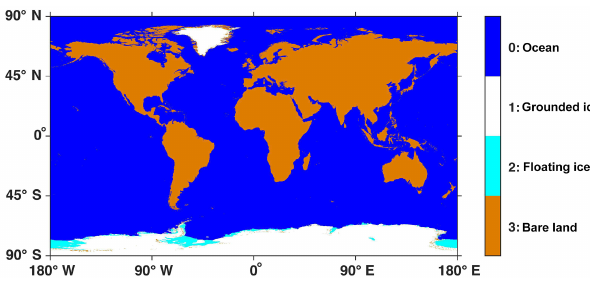
Figure 7. Global surface type mask (compare with Fig. 7 in Tim- mermann et al. (2010), but Greenland ice sheet